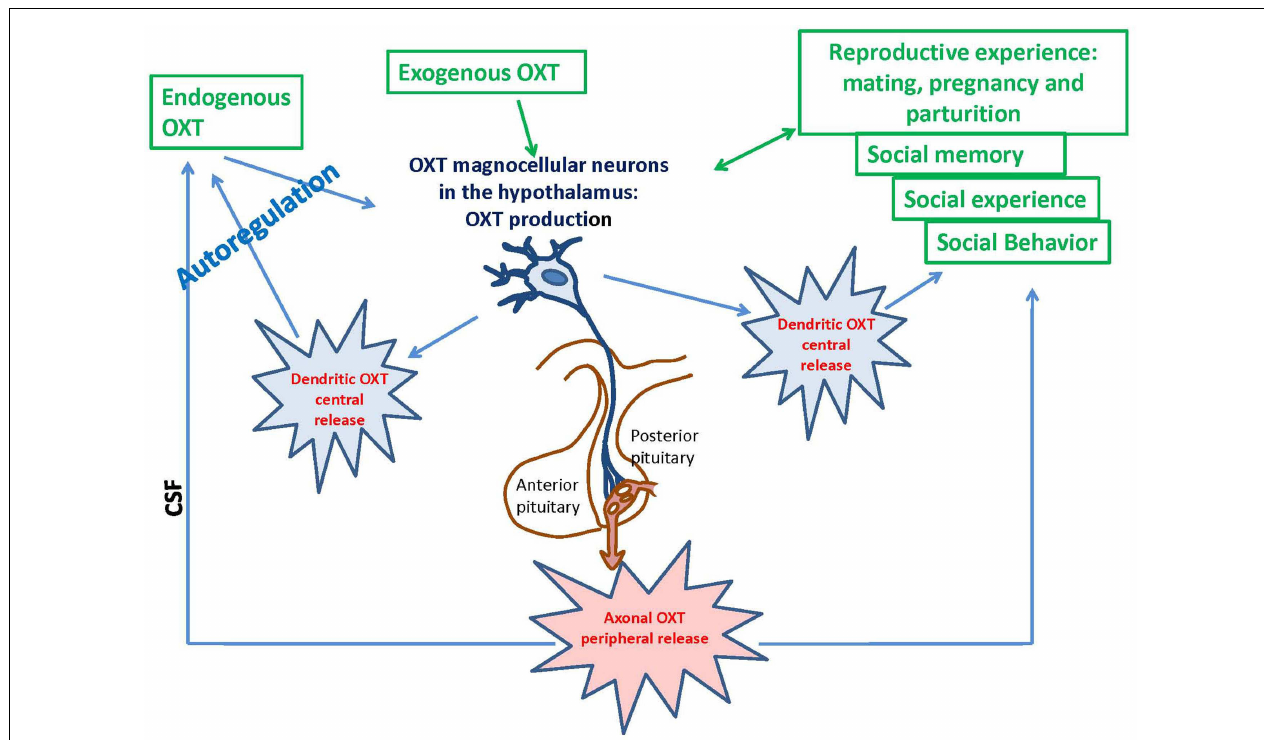
FIGURE 1 | Deletion of the Cd38 gene affectsADP-ribosyl cyclase activity, oxytocin release, and social behavior in male mice throughout their lifespans: significance of